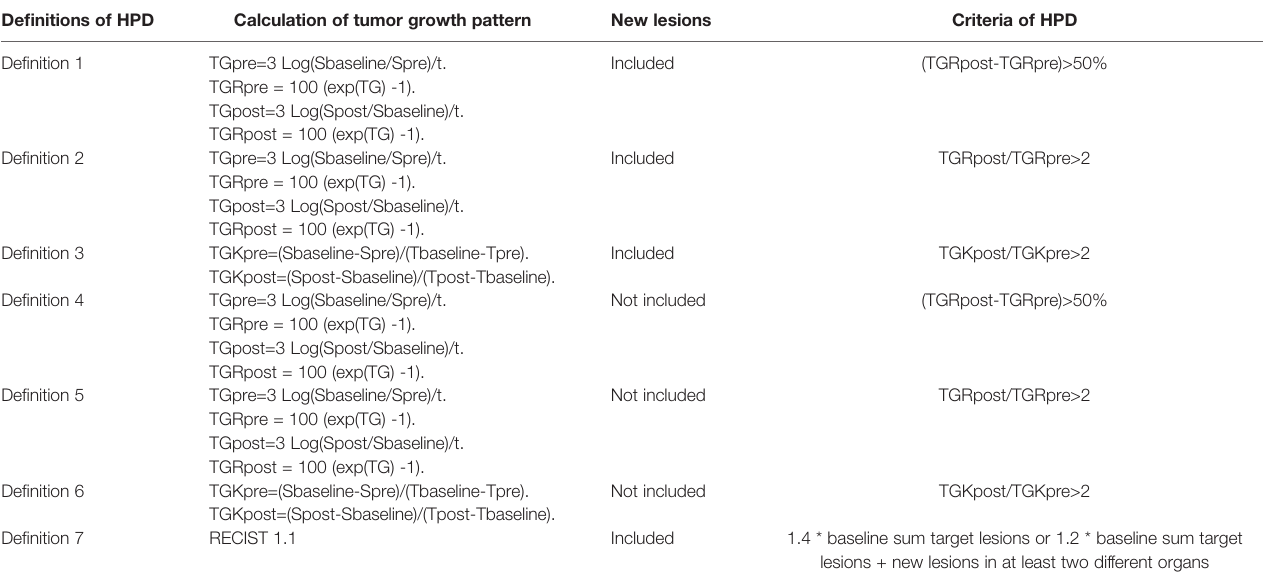
TABLE 1 | De fi nitions of hyperprogressive